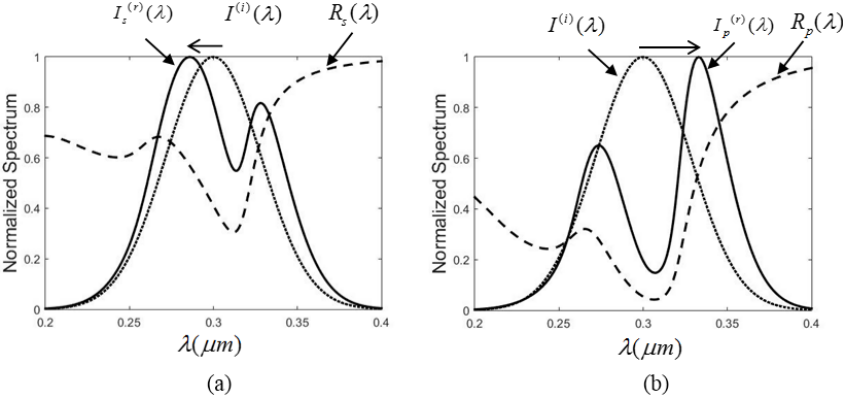
s ( λ ) and R p ( λ ) of water; ( b ) The reflectance of R s ( λ ) and R p ( λ ) of Ag. Metals 2016 , 6 , 7